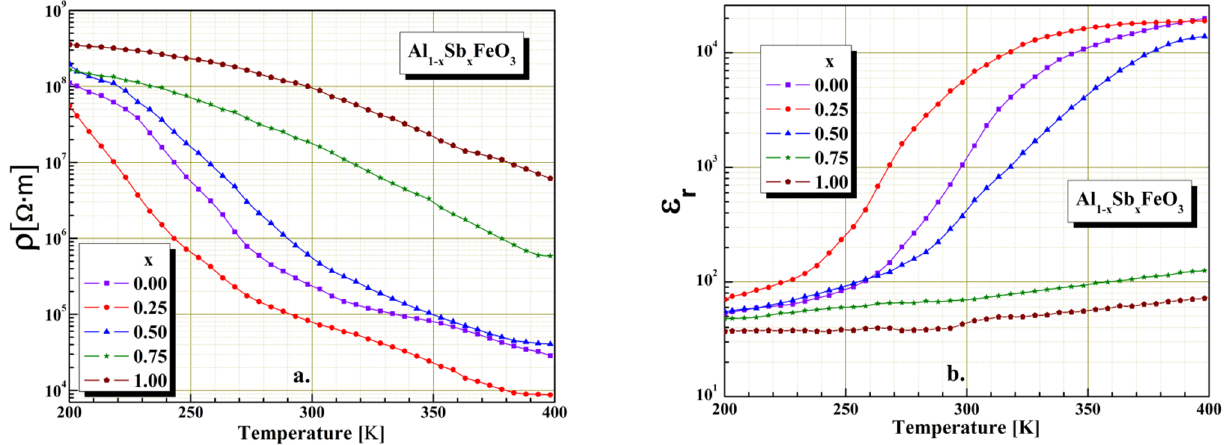
Figure 6. The temperature influence on electrical resistivity ( a ) and relative permittivity ( b ) at 20Hz fixed frequencyfor Al 1-x Sb x FeO 3 perovskites.